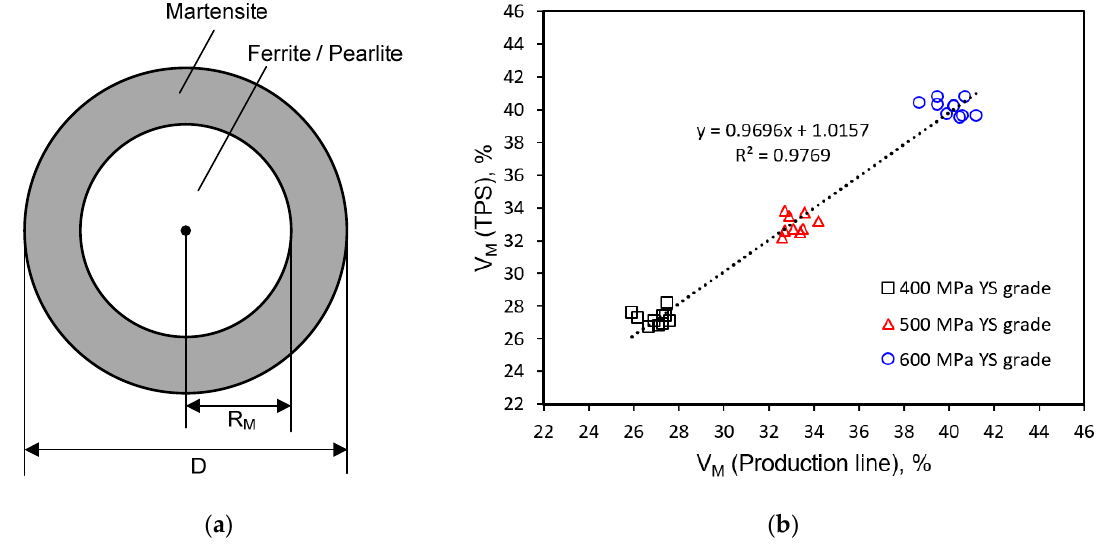
Figure 14. ( a ) Definition of martensite volume fraction; ( b ) correlation of martensite volume fraction.